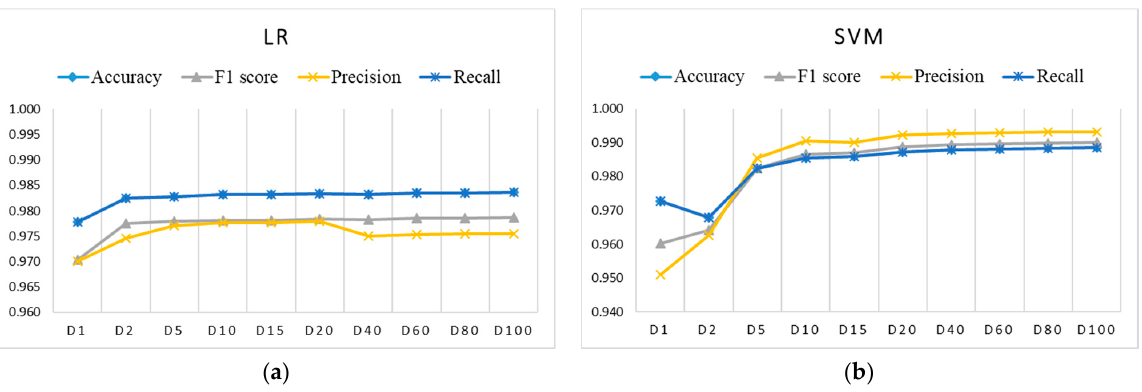
Figure 6. Evaluation results on test dataset for imbalanced training datasets Di using: ( a ) LR (coincidence of accuracy and recall); ( b ) SVM (coincidence of accuracy and recall).